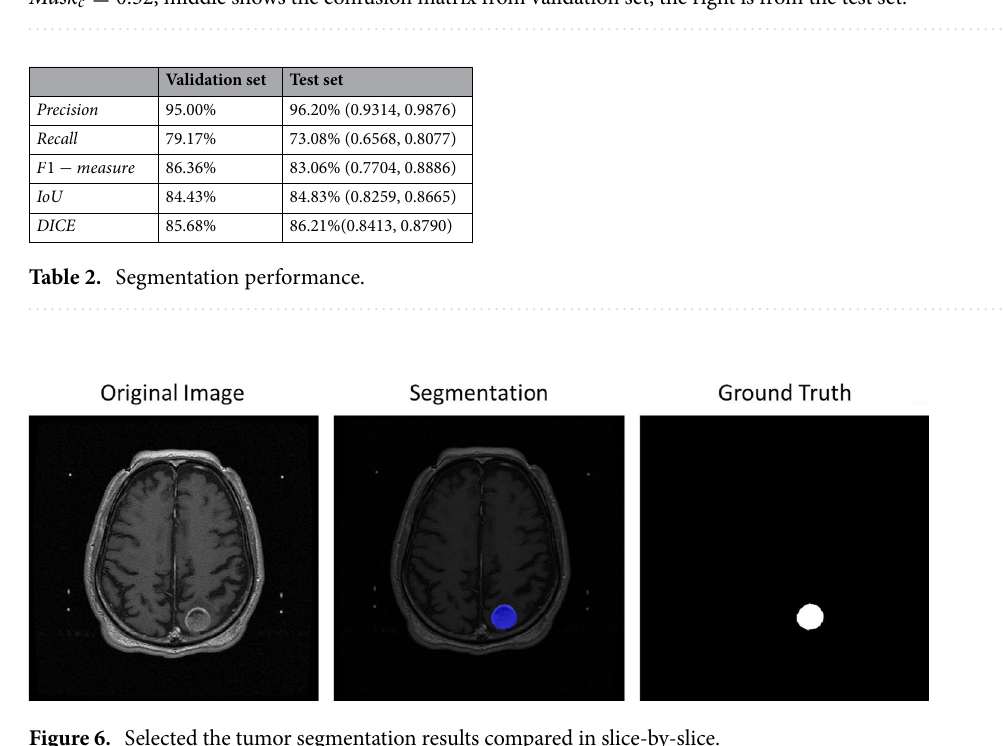
Figure 5. The result in segmentation. The left is the PR curve of the detection rate of tumors. At the Mask c = 0.52 , middle shows the confusion matrix from validation set, the right is from the test set.